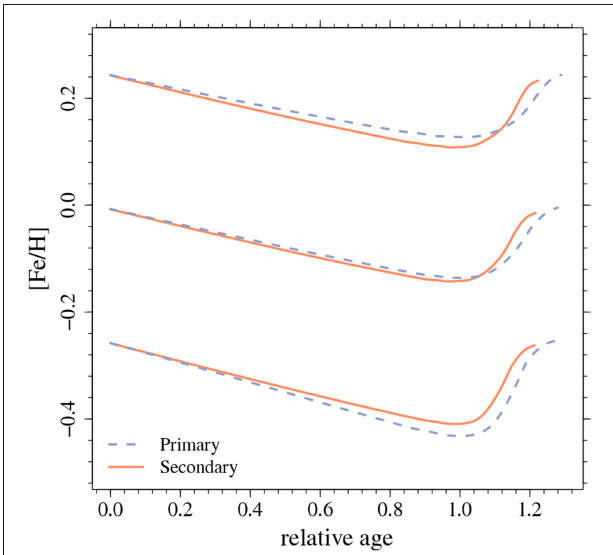
FIGURE 1 | Evolution of the surface [Fe/H] for primary (dashed lines) and secondary (solid lines) stars as a function of the stellar relative age (relative age is 0.0 at ZAMS and 1.0 at the end of the MS). Models for the three assumed initial metallicities are represented.